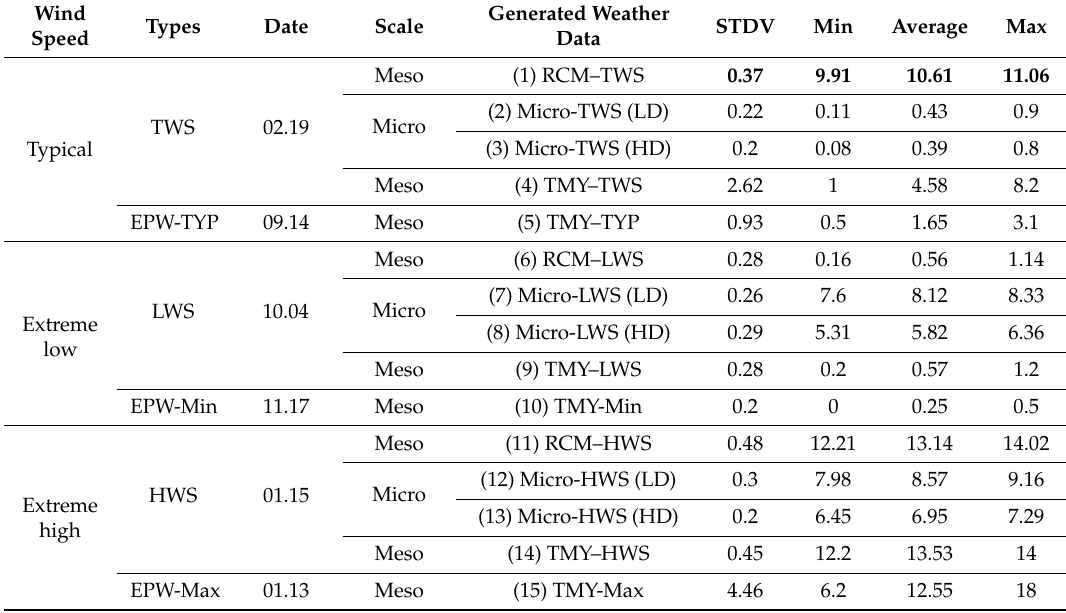
Table 1. The details of fifteen generated weather datasets in the study for energy performance simulations (EPS); mesoscale data: regional climate models (RCM) and typical meteorological year (TMY), microscale data: micro in typical and extreme low and high wind